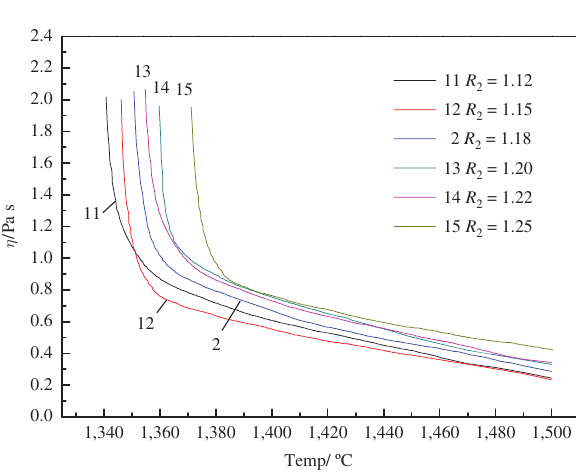
Figure 8: CaO – SiO 2 – MgO – Al 2 O 3 quadruple phase diagram (Al 2 O 3 % ¼ 15%).